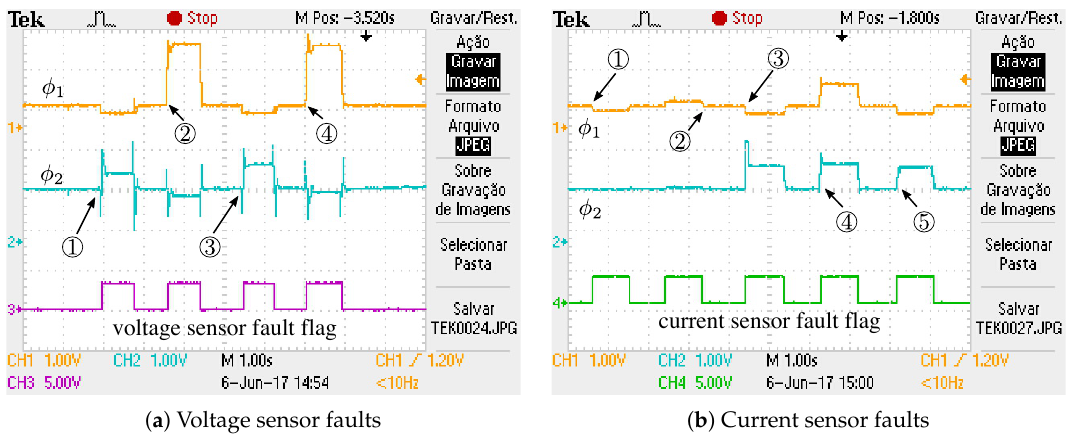
Figure 17. Experimental FDI in sensors using φ 1 and φ 2